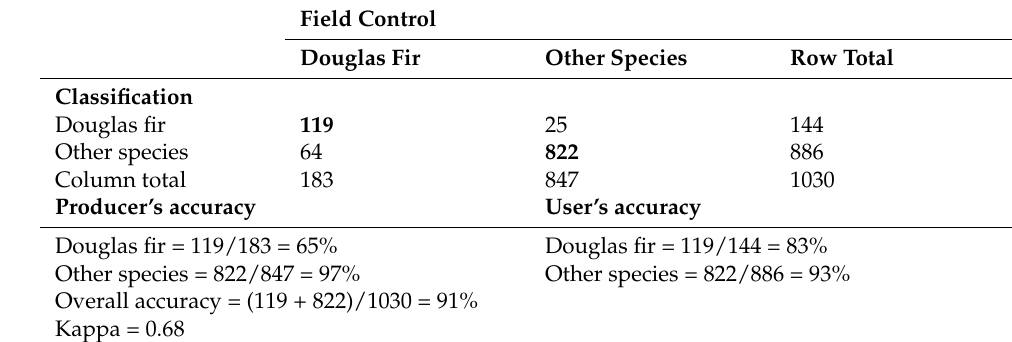
Table 12. Confusion matrix for Douglas fir trees based on the Dalponte2016 segmentation method. Species were modeled based on mean return intensity. Segments were classified using a logistic generalized linear mixed model with a plot held as a random